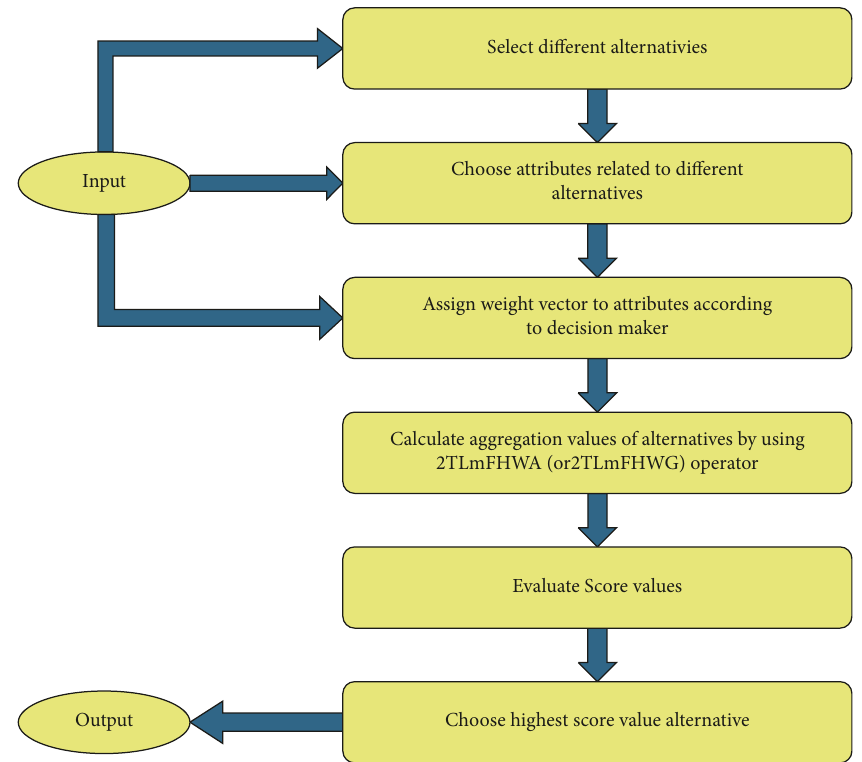
Figure 2: Flow chart for decision-making by using the 2TLmFHWA(or2TLmFHWG)